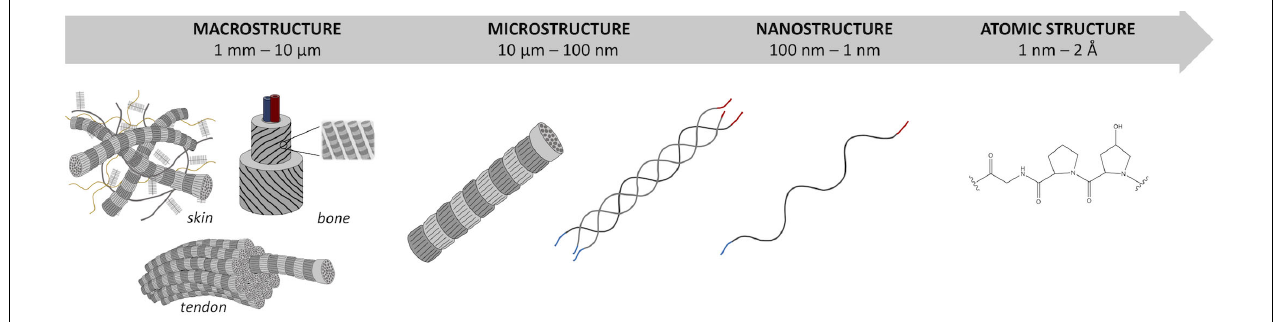
FIGURE 1 | Hierarchical organization of type I collagen skin, tendon, and bone from macroscale to atomic scale.